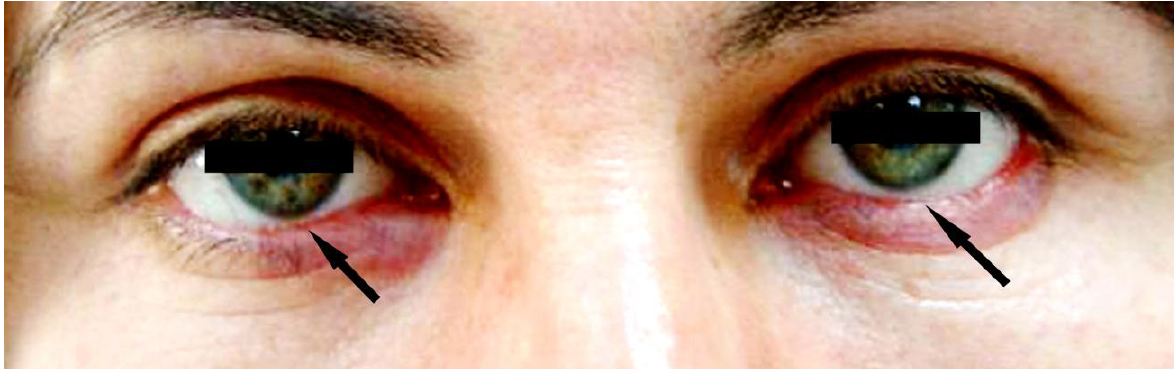
FIGURE 1 . Edematous, erythematous plaques of the lower eyelids with madarosis